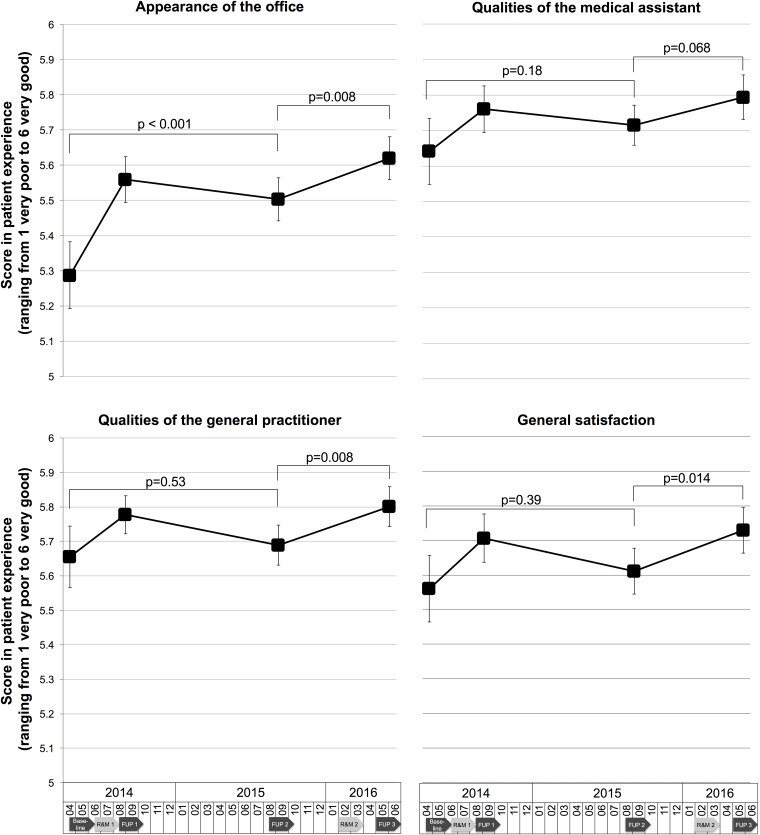
Patient experience in four domains at baseline and during follow-up (unadjusted).Y axis restricted to a score from 5 to 6. X axis represents time in months. P-values from univariate regression models. R&M = renovation and modernization, FUP = follow-up.